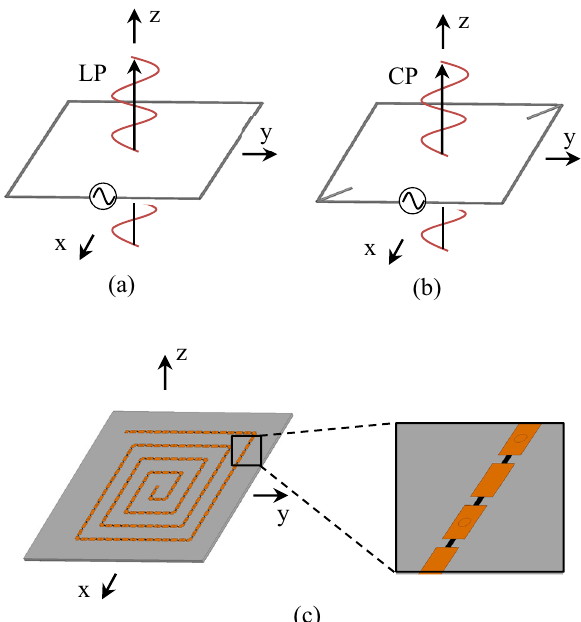
Fig. 1. (a) Conventional loop antenna that forms linearly polarizedbidirectional radiation. (b) Loop antennawith perturba- tion elements that form circularly polarized radiation. (c) Metaspiral antenna that forms circularly polarized radiation.